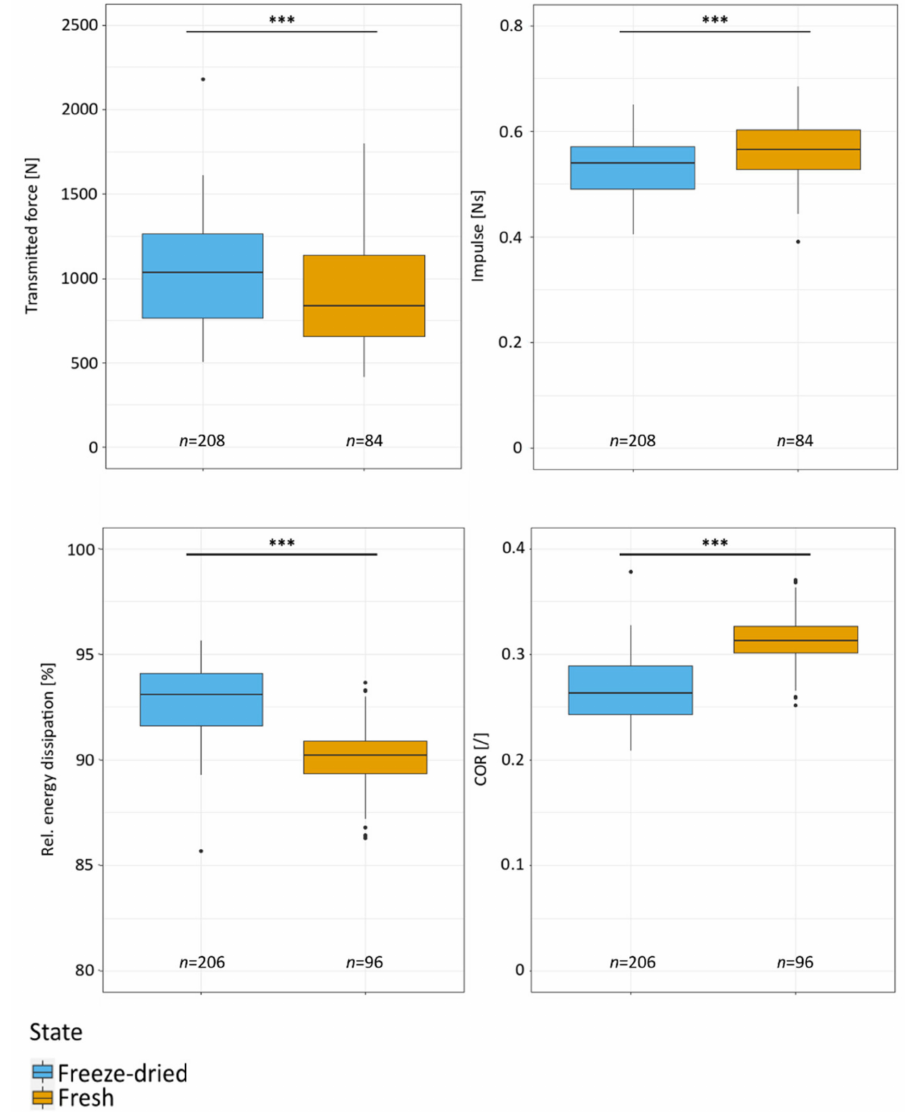
Figure 6. Comparison of fresh and freeze-dried samples of Citrus × limon . Drop-weight tests with an impactor (mass 0.061 kg) dropped from a 0.81-m height. The level of statistical significance is indicated in the figure as follows: n.s.: p ≥ 0.05; ***: p <